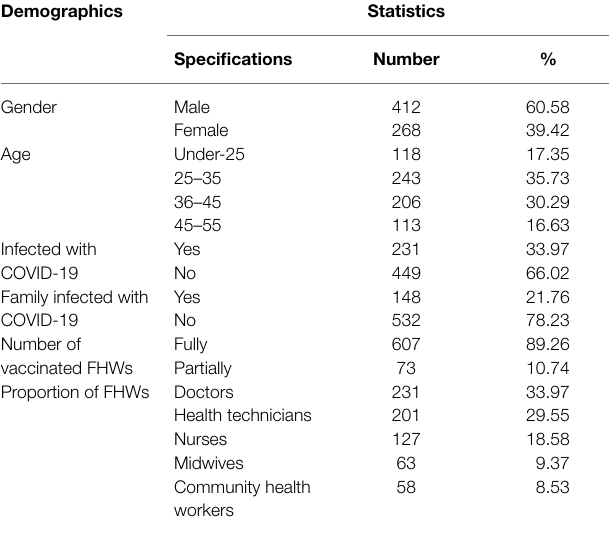
TABLE 1 | Characteristics of participants ( n =